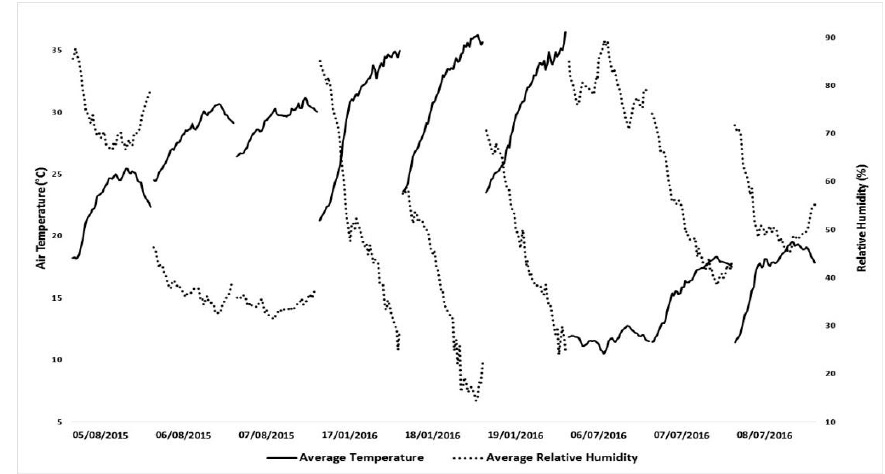
Figure 2. Mean air temperature and relative air humidity for the period of analysis.